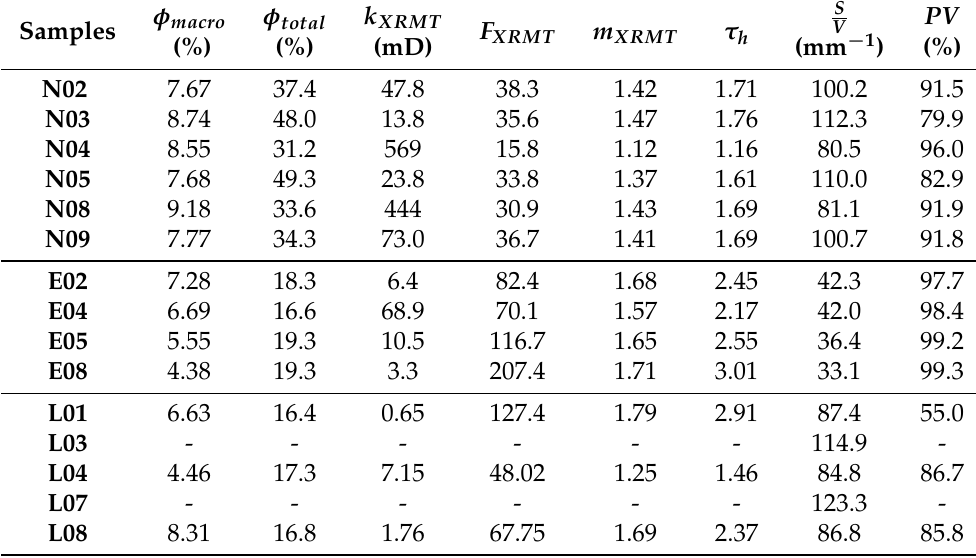
Table 2. Petrophysical parameters summary from tomography images: macro-void porosity φ macro (%), total-phase porosity φ total (%), permeability k XRMT (mD), formation factor F XRMT , cementation index m XRMT and hydraulic tortuosity τ h , ratio of pore surface over pore volume S of percolating volume PV (%). The - stands for non-percolating